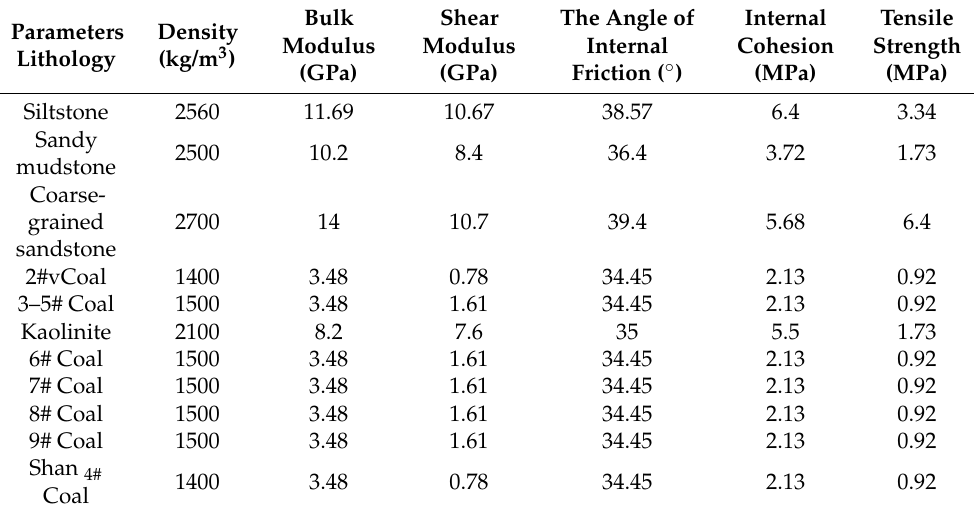
Figure 5. Numerical model perspective view. Table 1. Rock mechanics parameter